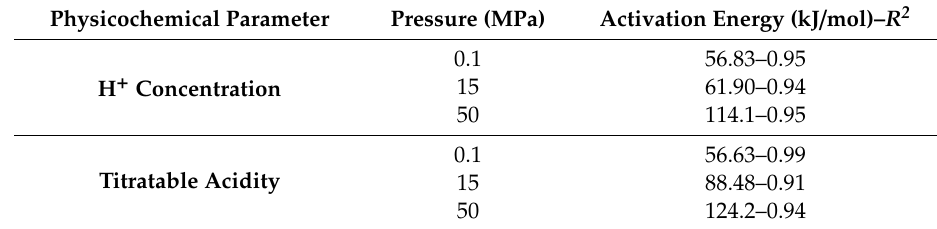
Table 3. Activation energies (kJ / mol) of each physicochemical parameter analyzed for fermentation at 0.1, 15, and 50 MPa.